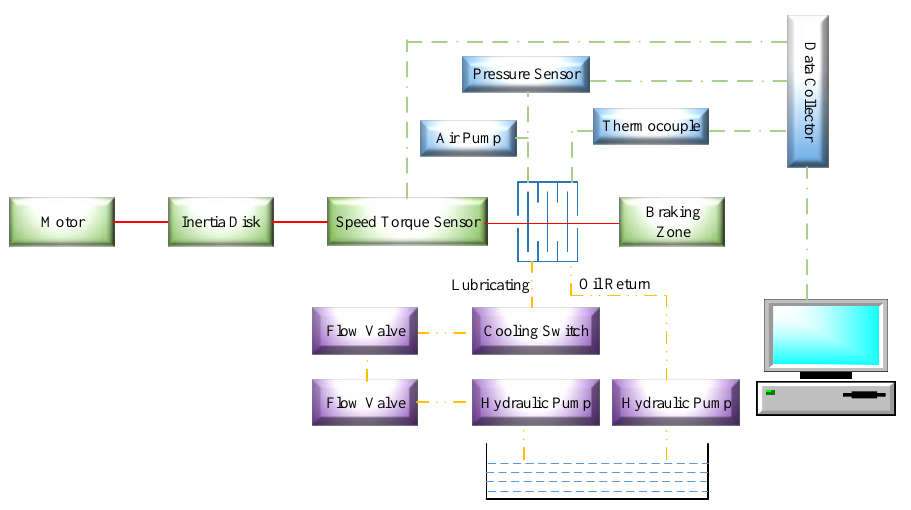
Figure 10. SAE# 2 test machine schematic diagram.